Question: Compose a caption that would accompany this figure in a paper.
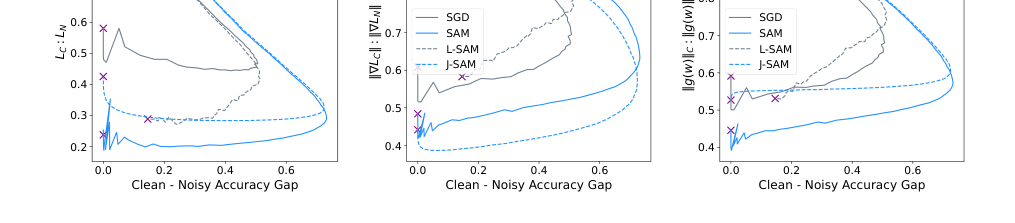
Answer: We plot the clean/noisy ratio of the loss, sample-wise gradient norm, and logit scale norm versus the clean-noisy accuracy gap. The ratios are higher with SAM and J-SAM than SGD and L-SAM for the same accuracy gap. Orange marker denotes the beginning of the training trajectory and purple denotes the end.